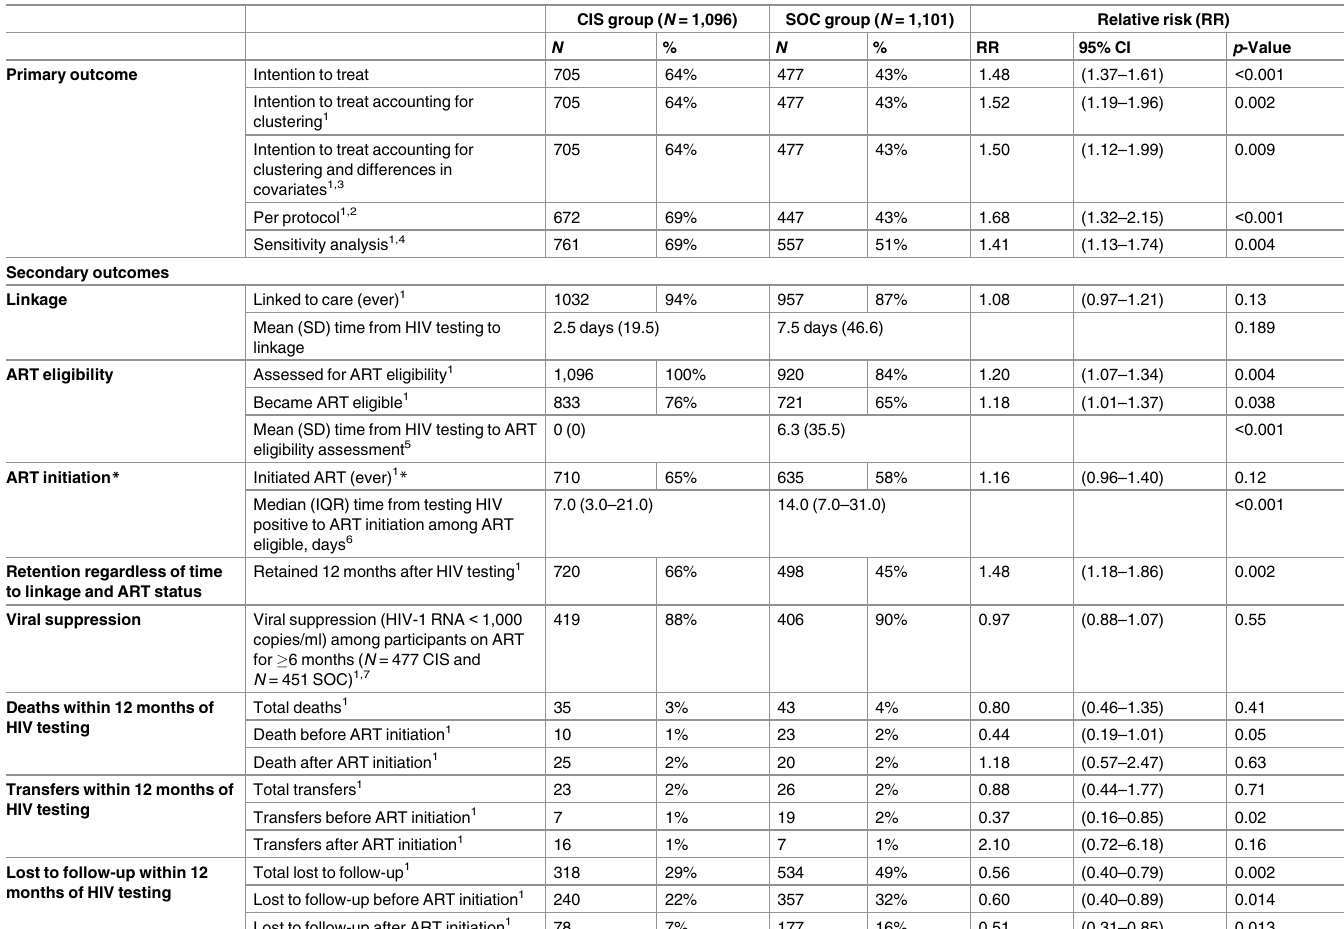
Table 3. Primary and secondary outcomes for the combination intervention strategy (CIS) and standard of care (SOC) study arms.